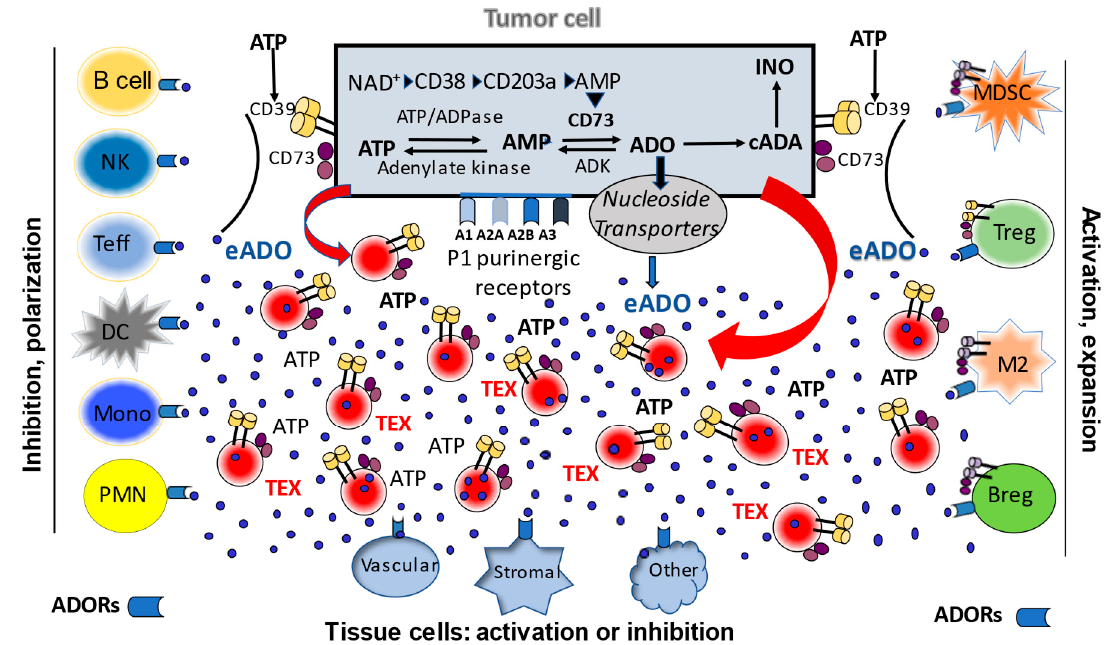
Figure 1. A schematic view of intracellular and extracellular adenosinergic pathways in the tumor microenvironment (TME). Tumor cells operate a canonical ATP/CD39/CD73 pathway and non-canonical NAD + CD38/CD203 pathway. The canonical pathway involves sequential hydrolysis of ATP to ADP to AMP mediated by CD39 and CD73 to produce ADO. The non-canonical pathway involves the use of NAD + as a substrate by CD38 to generate ADP-ribose, which is processed by CD203a to AMP and then by CD73 to ADO. Once generated, ADO is either metabolized to inosine by adenosine deaminase (cADA) or transported to the extracellular space by nucleoside transporters. Extracelular (e)ADO interacts with ADORs (type 1 purinergic (P1) receptors) broadly expressed on all cells in the TME, including tumor cells. ADO signals may be inhibitory or stimulatory, depending on the type of adenosine receptors (ADORs: A1, A2a, A2b, A3). Tumor cells produce and release extracellular vesicles called exosomes (TEX). These are released into extracellular space in large numbers and carry surface ectonucleotidases CD39/CD73. In the presence of ATP excess in the TME, TEX produce ADO. They also carry intraluminal ADO and deliver it to recipient cells upon uptake into cytosol. TEX also deliver biologically active CD39/CD73 to recipient cells, providing them with the enzymatic capability to metabolize ATP into ADO. TEX emerge as a major driver of ADO-mediated signaling in the TME.